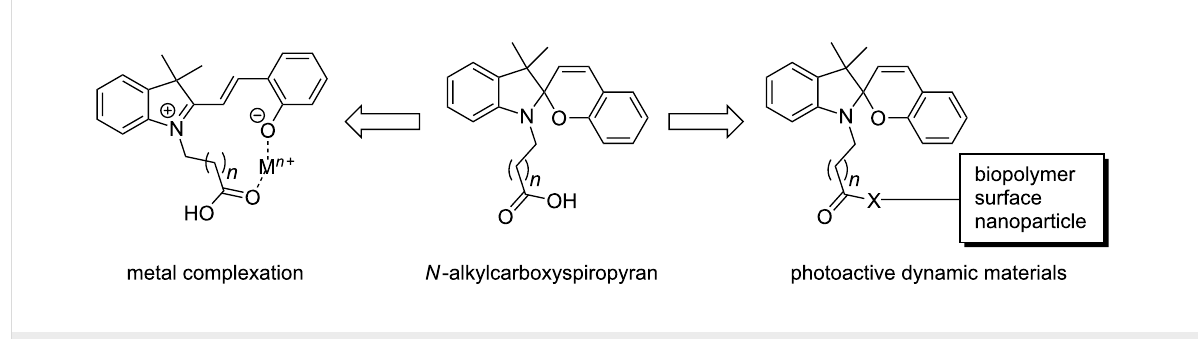
Figure 1: General uses of N -alkylcarboxyspiropyrans.